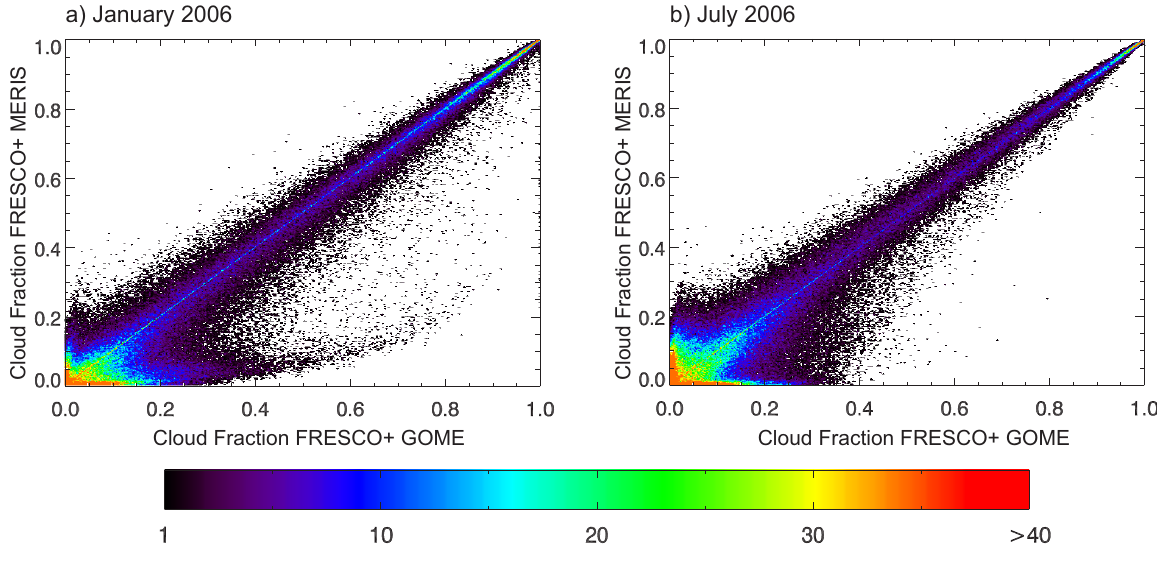
Fig. 7. Scatter density plots of FRESCO+MERIS effective cloud fraction as a function of FRESCO+GOME effective cloud fraction for January (left) and July 2006 (right). Only snow/ice-free values over land are